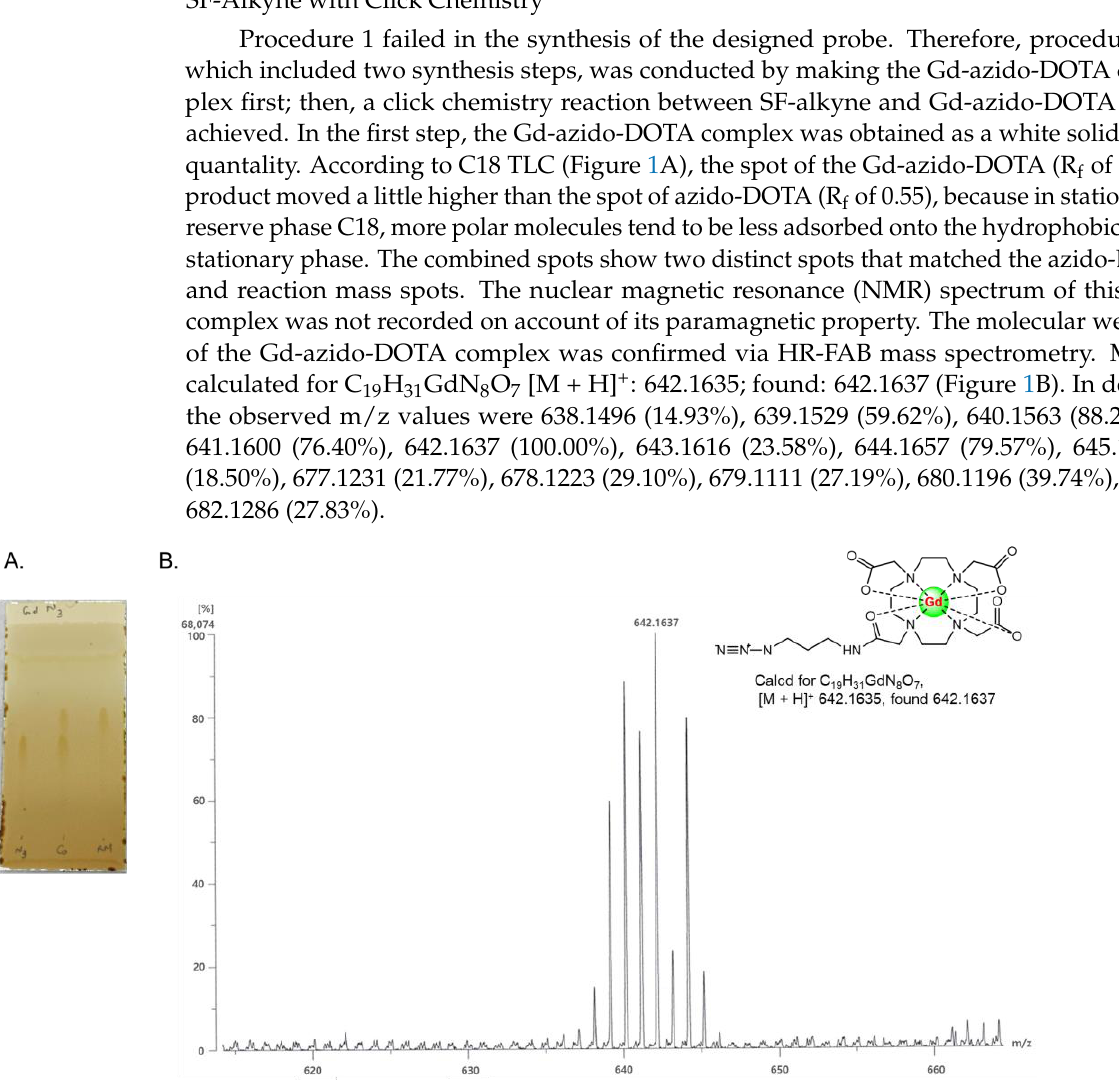
Figure 1. Thin-layer chromatography (TLC) to follow the reaction of Gd-azido-DOTA ( A ) (N 3 , az- ido-DOTA; Co, combined spots azido-DOTA and reaction mass; RM, reaction mass). HR-FAB mass spectrum of Gd-azido-DOTA ( B ). spectrum of Gd-azido-DOTA ( B